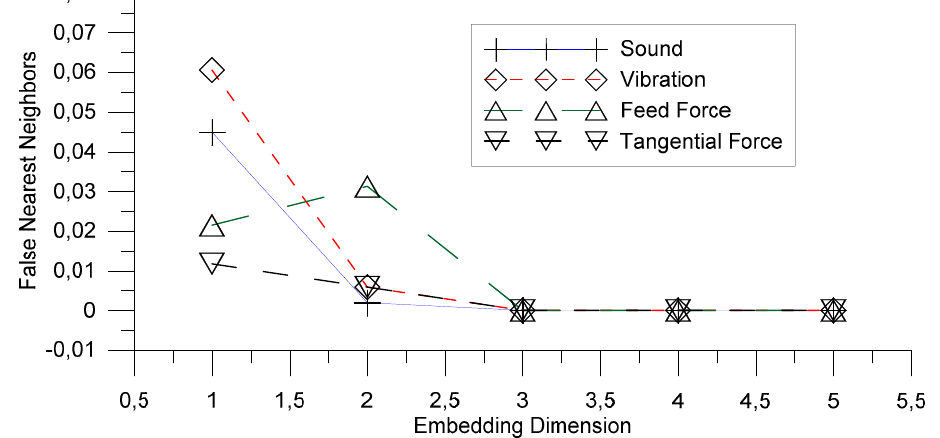
Figure 5. False nearest neighbors of acquired sensor data for worn inserts versus embedding dimen- sion.